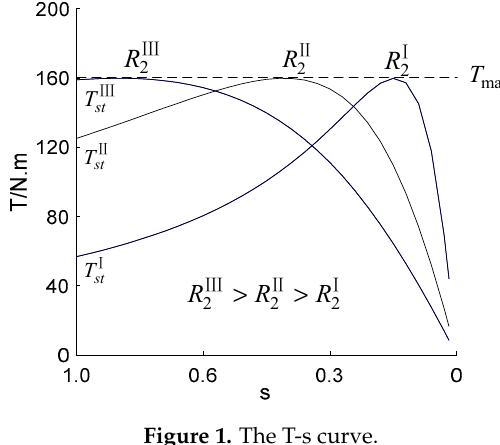
Figure 1. The T-s curve.